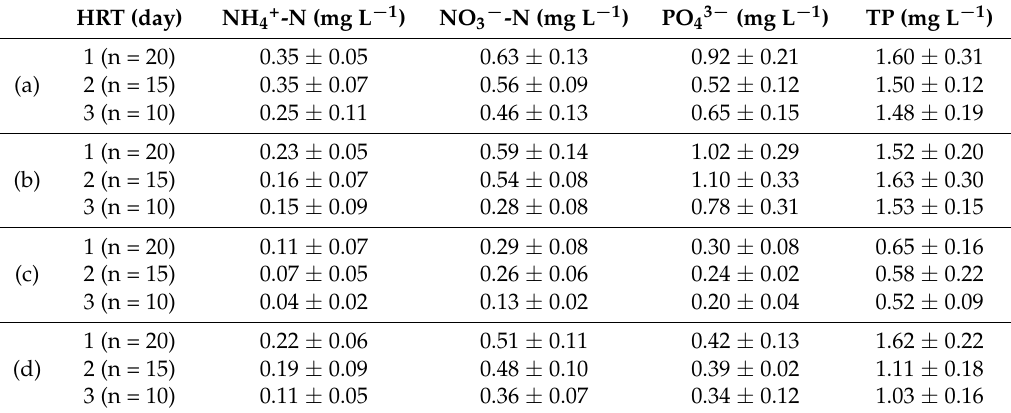
Table 3. The mean effluent concentrations of nitrogen and phosphorus (mg L − 1 ) for bioretention